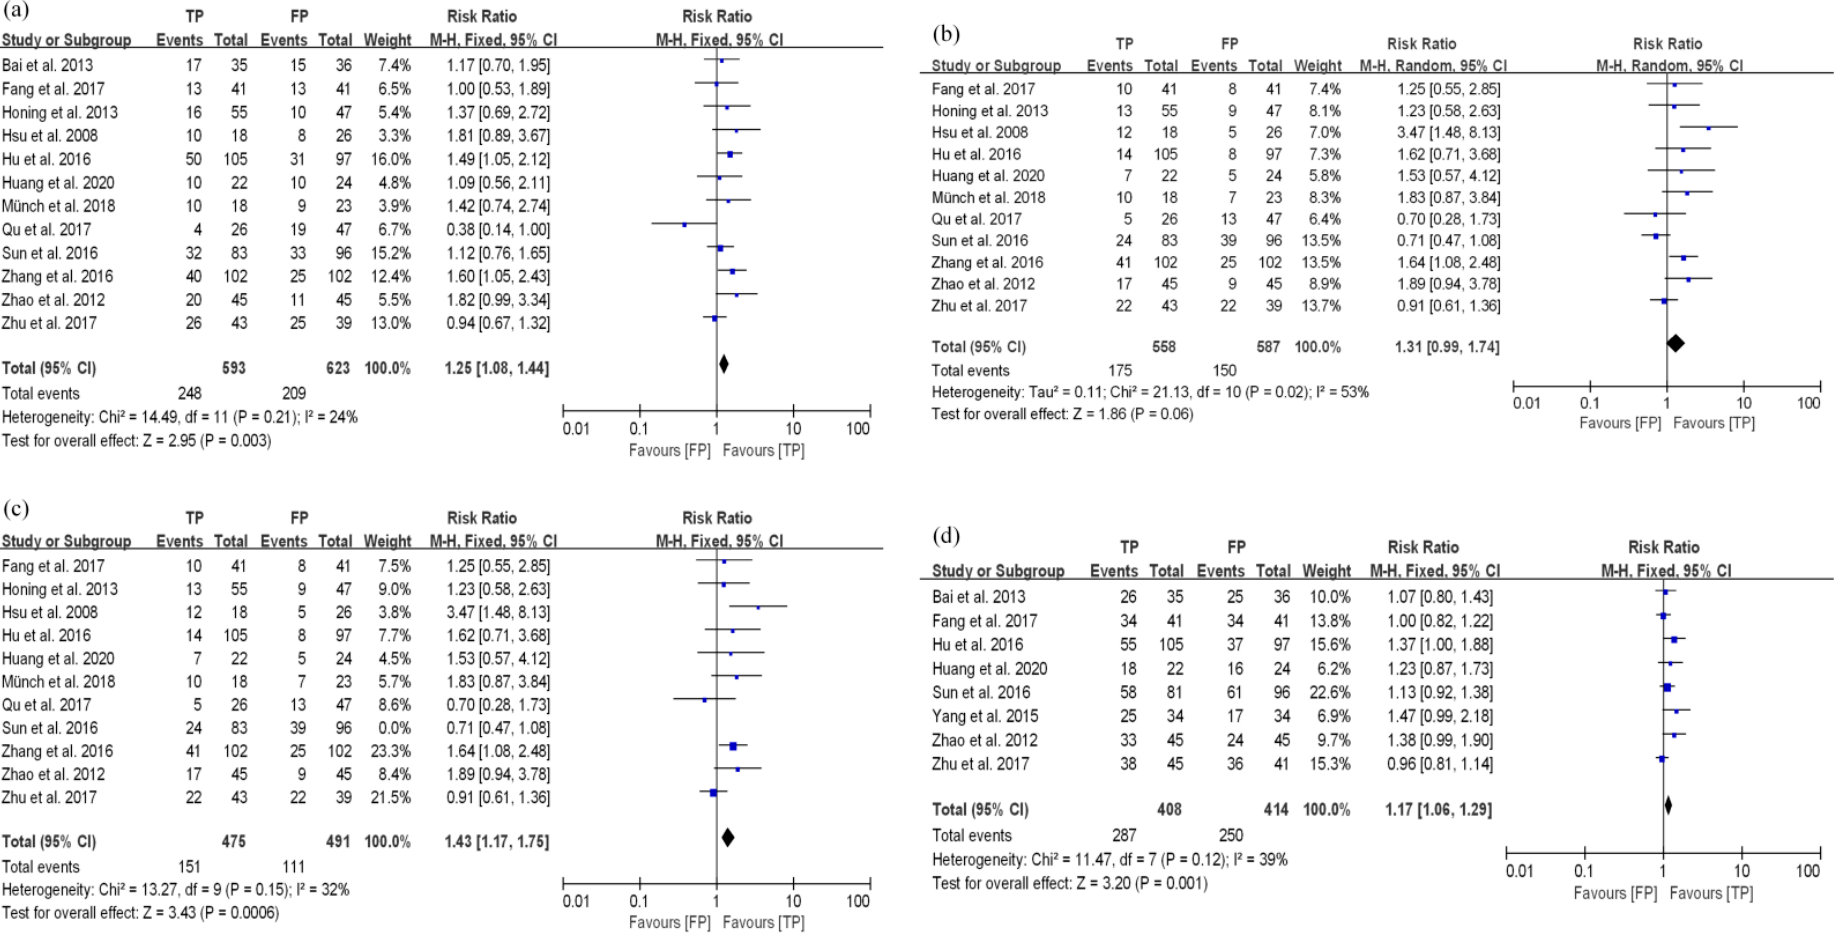
Figure 3. Analyses of curative effects in TP and FP groups in EC patients treated with dCRT. ( a ) 3-year OS; ( b ) 3-year PFS; ( c ) 3-year PFS after correction; ( d ) ORR.